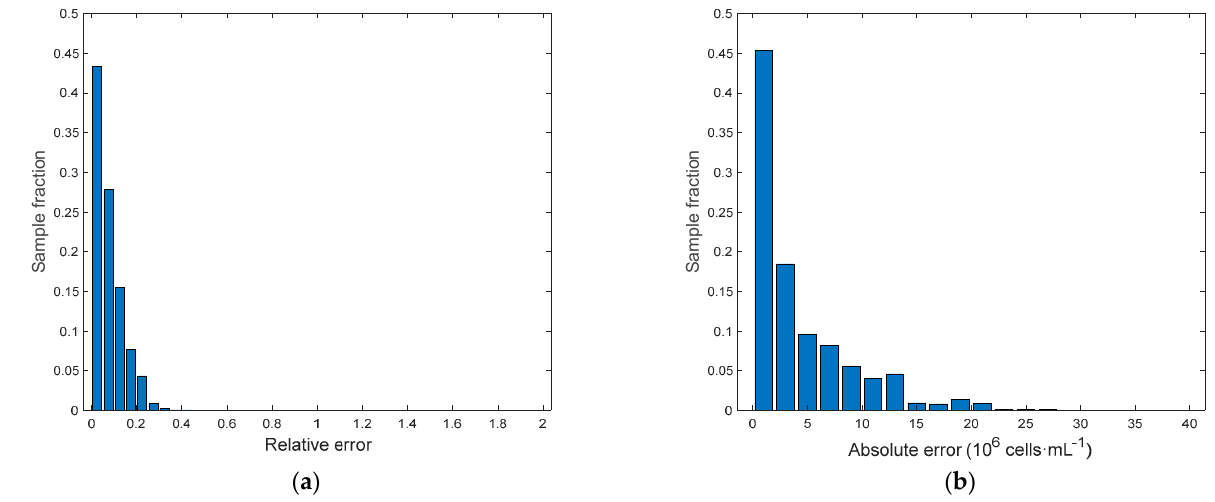
Figure 11. Model D[ 𝐗 𝐂𝐈 |𝐗 𝐅𝐈 ‖ ln(C x )]. ( a ) Relative error distribution. ( b ) Absolute error distribution.